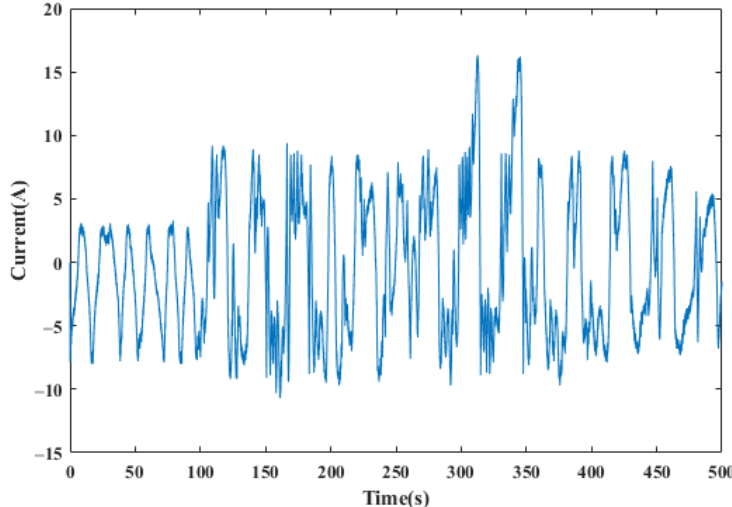
Figure 18. Steering angle tracking effect when driving on sloping terrain.